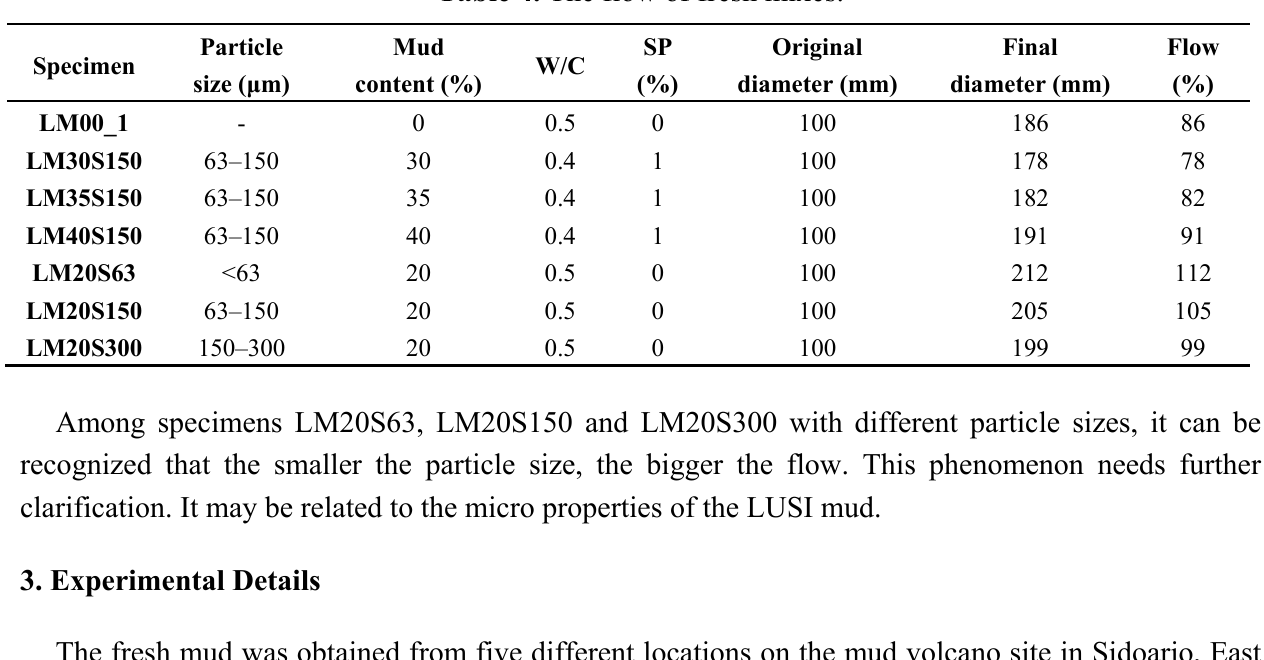
Table 4. The flow of fresh